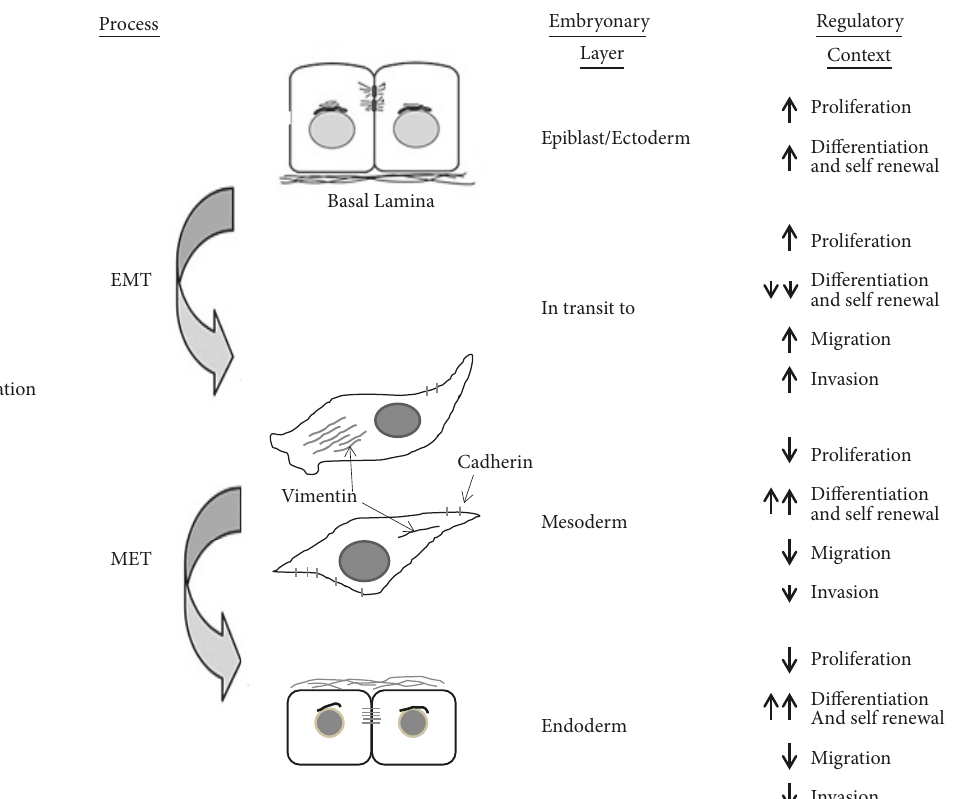
Figure 1: Differencesestablished during gastrulationthroughthe EMT and MET processes. Atthe end of gastrulationthe distinctgerm layers will be able to regulate and control, in a different way, the cellular processes such as proliferation, differentiation, migration, and invasion.